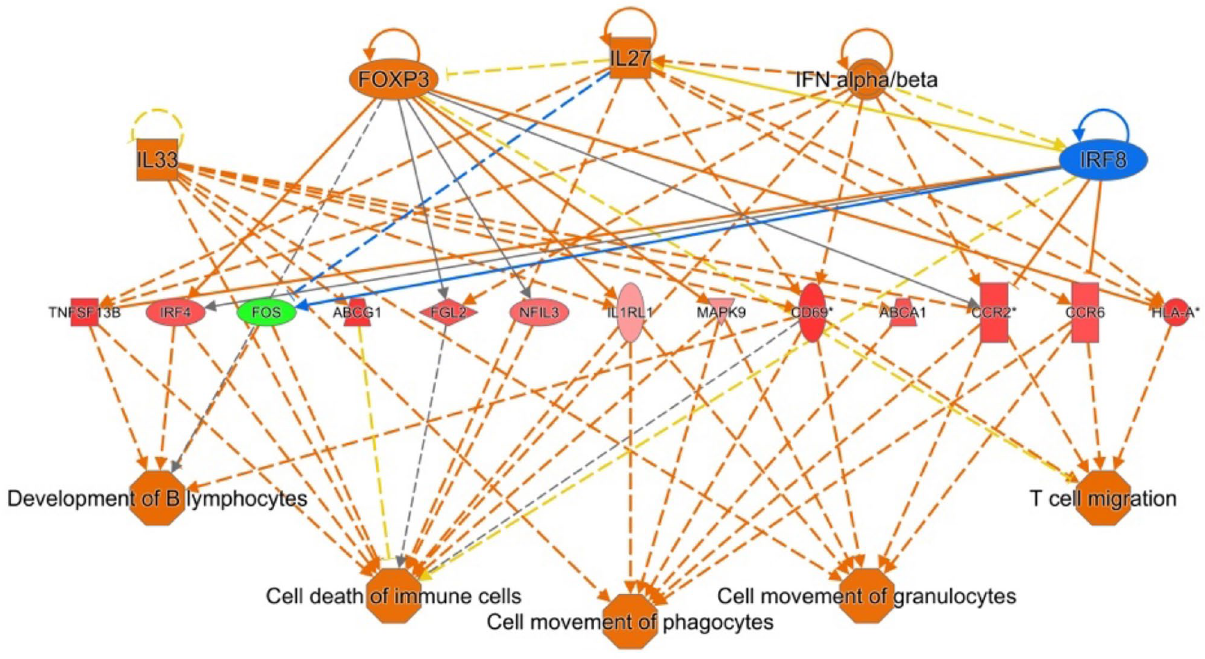
Figure 3. Top regulatory effect predicted by Ingenuity Pathway Analysis within Fayoumis at 6 dpi comparison. Blue (inhibited) and orange (activated) lines represent relationships with upstream regulators at the top of the figure with differentially expressed genes at center, and diseases/functions. Genes in green indicated down- regulation, while red signifies